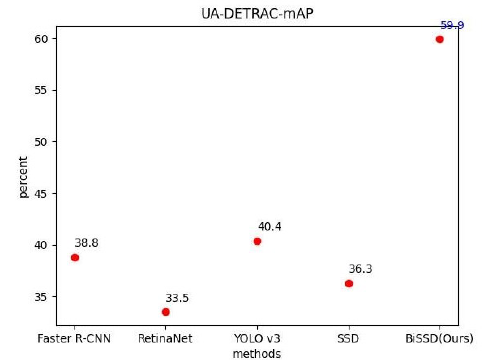
Figure 5. MAP index comparison of UA-DETRAC data set